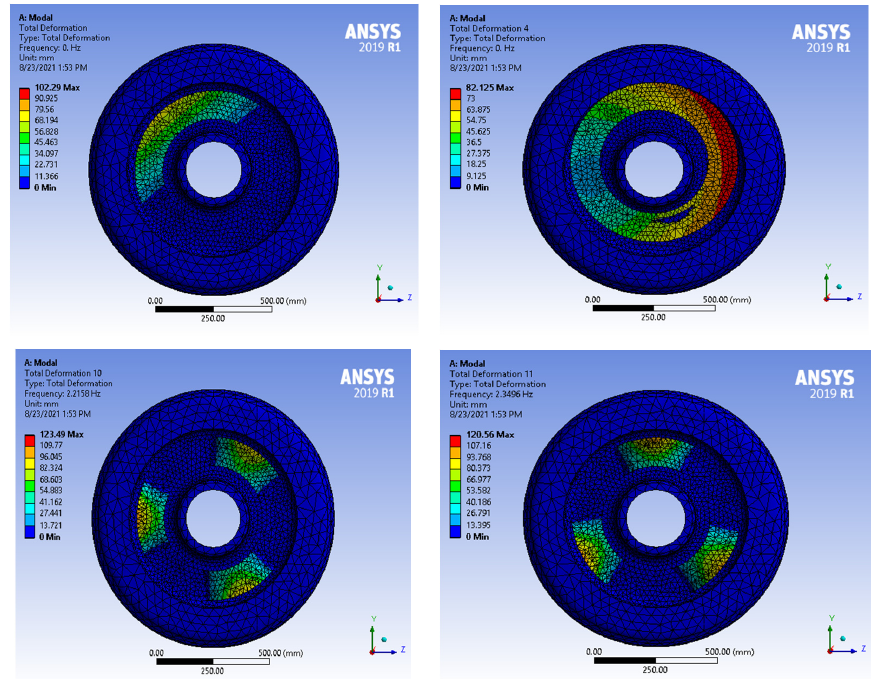
Figure A1. First four mode shapes of the wheel mounted with viscoelastic damping layer on the web.